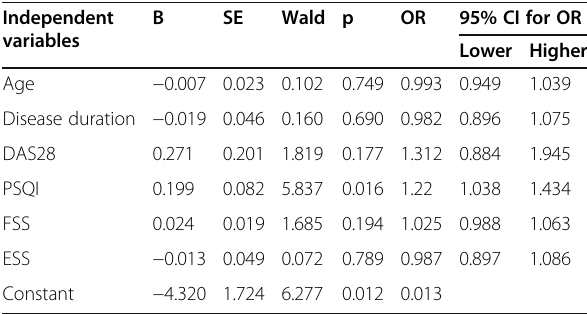
Definition of Abbreviations: BDI-II Beck Depression Inventory, DAS28 Disease activity score in 28 joint, PSQI Pittsburgh Sleep Quality Index, FSS Fatigue Severity Scale, B coefficients, OR Odds ratio, CI Confidence